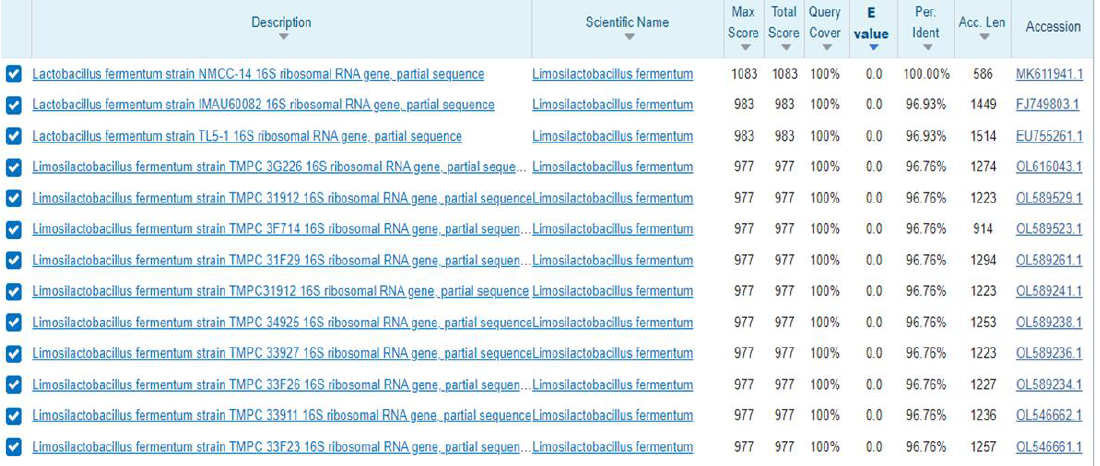
Figure 8. Phylogenetic tree of Lactobacillus fermentum NMCC-14 bacterial strain. Bootstrap values can be seen at each node.